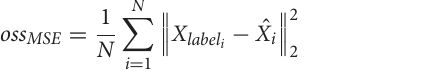
are implemented for fusing the feature maps to form the real and imaginary parts of k-space map of reconstructed